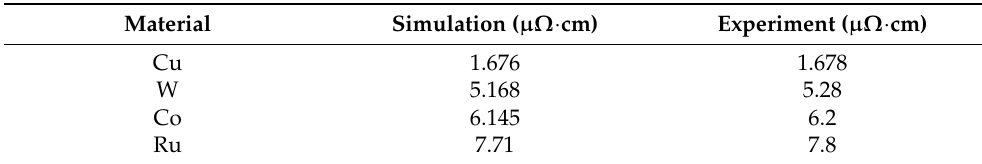
Figure 2. Bulk resistivity of ( a ) Cu, ( b ) Ru, ( c ) Co, and ( d ) W interconnect with the increase in time steps. Table 1. Comparison between simulation and experiment at 300